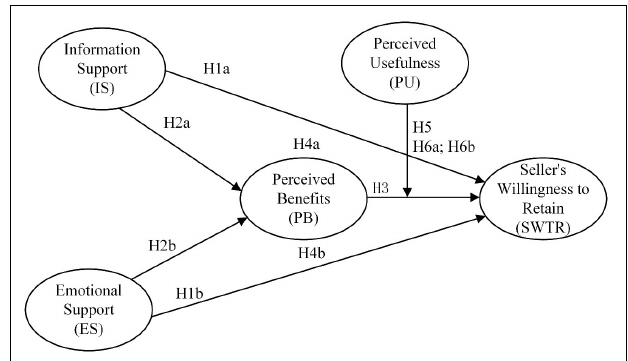
FIGURE 1 | Research model. H4a-Indirect influence of IS on SWTR; H4b-Indirect influence of ES on SWTR; H6a-the conditional indirect relationship of IS with SWTR (through PB); H6b-the conditional indirect relationship of ES with SETR (through